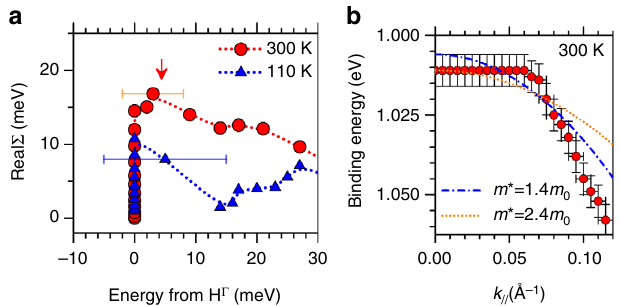
Fig. 4 Real part of Self Energy and hole effective mass. a Real part of quasiparticle self-energy ( Σ ) at 300 and 110 K (see inset in Figs 2b and 3b). The energy values were evaluated with respect to the H peak position at Γ point (H Γ ), the error bar being ± 5 meV (at 300 K) and ± 10 meV (at 110 K) as resulting from the EDCs peak fi tting procedure b Experimental H band dispersion near Γ point region at 300 K, with corresponding energy error bars ( ± 5 meV). The band curvature close to Γ point was estimated by means of parabolic curves centered at Γ within the [0 – 0.07] Å − 1 wave vector range, where kink is observed, and corresponding effective mass value was map and the results of second derivative analysis are plotted in Fig. 3a, b, respectively. At low temperature the kink-like feature near Γ point is no longer visible, with the curvature of the H band well reproduced by the theoretical calculations. With respect to 300 K measurements, no signi fi cant changes in the energy gap size and position were detected, as well in the energy width of the